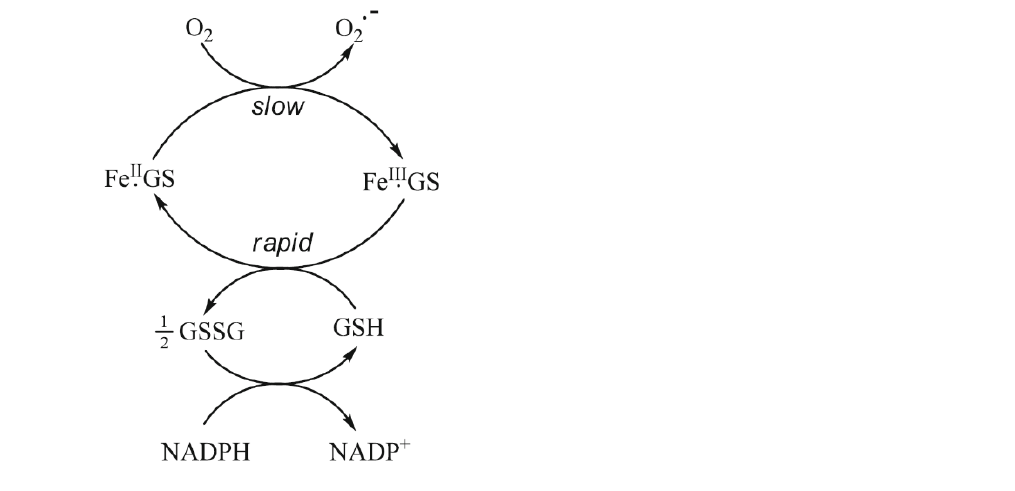
Figure 3. The buffering of cytoplasmic iron(II) by GSH. Although there is predicted to be a slow rate of autoxidation of Fe II · GS, the resulting Fe III · GS will be rapidly reduced back to Fe II · GS by the presence of the large excess of GSH.